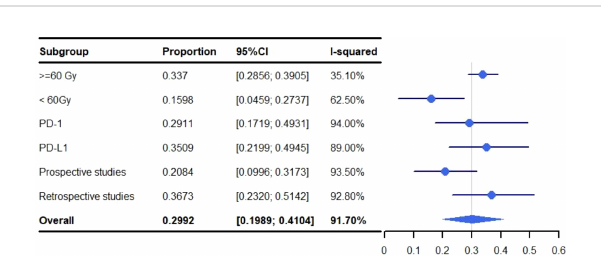
FIGURE 6 Subgroup analysis of meta-analysis and forest plot for non-small cell lung cancer patients treated with radiotherapy/chemoradiotherapy and immune checkpoint inhibitors who experienced grade 1-5